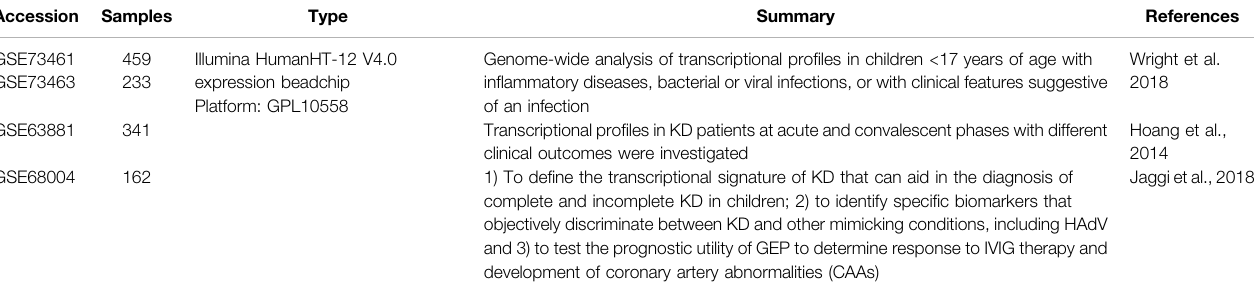
TABLE 2 | List of the datasets included in the study.